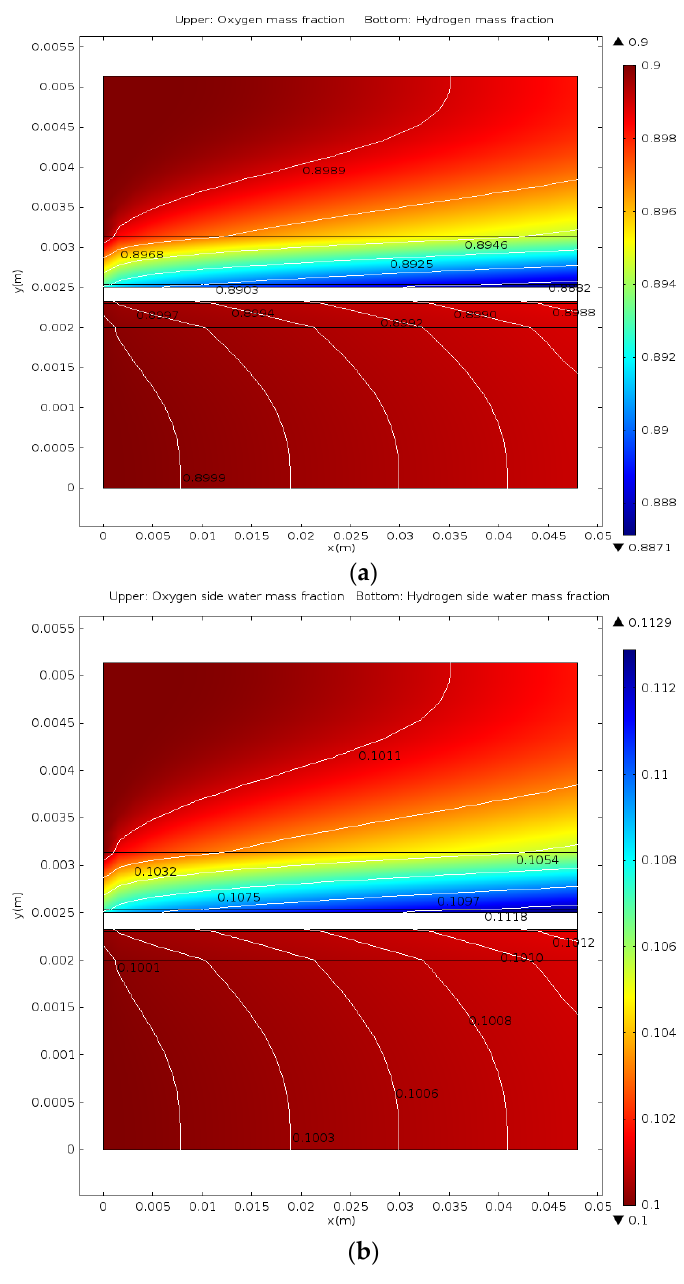
Figure 10. Cont . Figure 10.